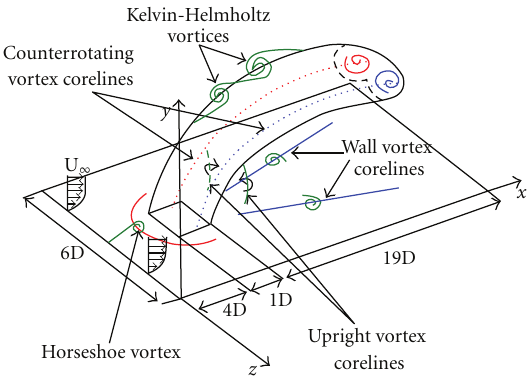
Figure 1: A schematic view of large vortex structures in single JICF.